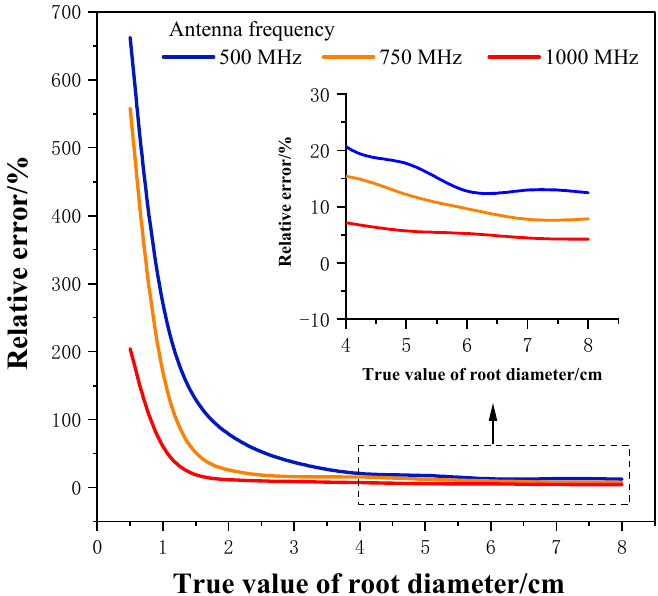
Figure 15. Change of relative errors of root diameter estimation. Table 3. Pre-buried root test